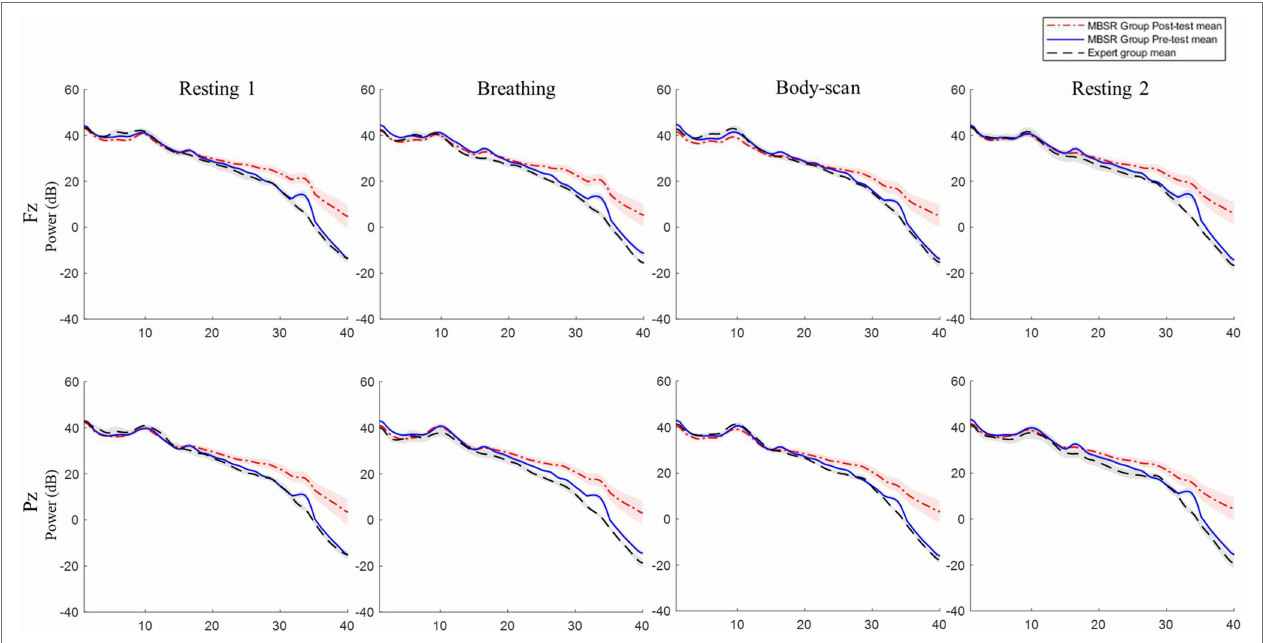
FIGURE 6 | MBSR group and expert EEG power comparison. MBSR group n = 17, expert group n = 5. Shading represents standard error of mean. No significant difference was found between expert group and the MBSR